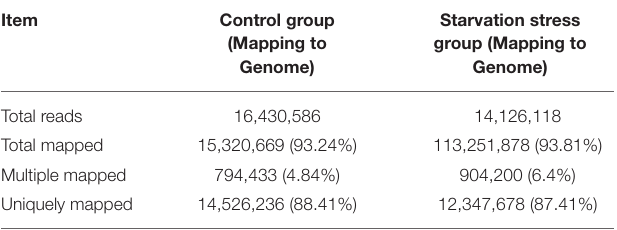
TABLE 4 | Summary of the reads mapping to the reference transcriptome of the control group and the starvation stress group. Item